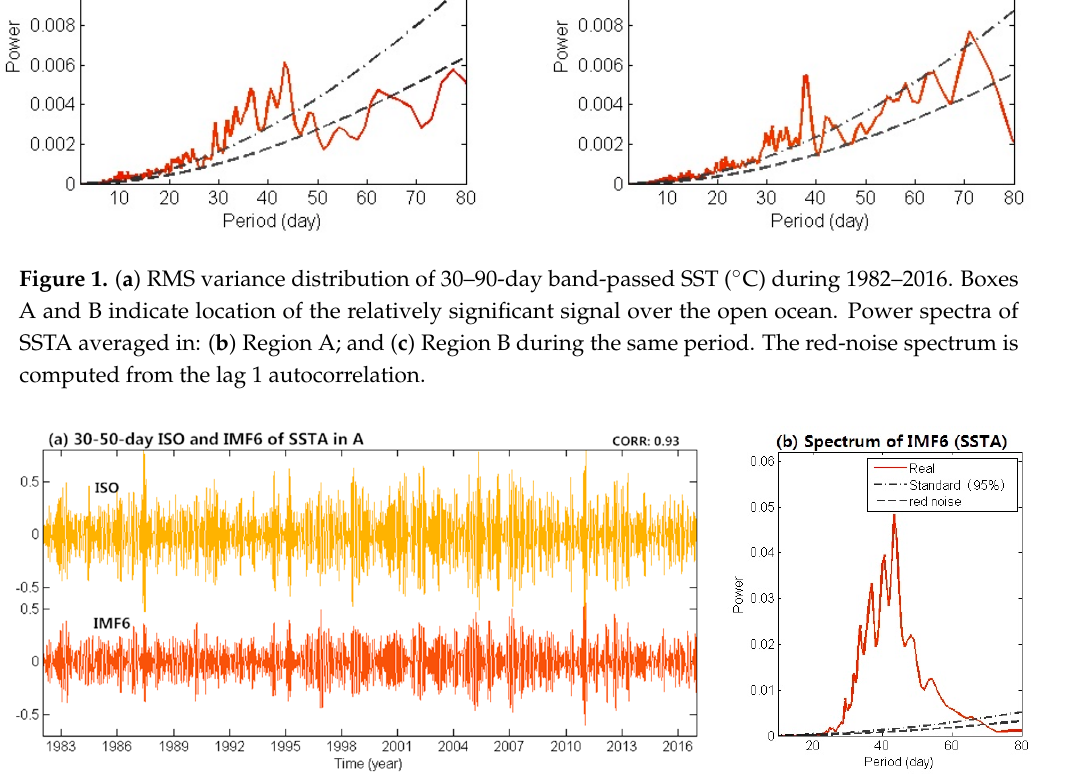
Figure 2. ( a ) The 30 – 50-day ISO (yellow) and IMF6 (red) of SSTA averaged in Region A. Correlation coefficient of the two time-series is 0.93. This result exceeds 95% confidence level by student t-test. ( b ) Spectrum of IMF6. The red-noise spectrum is computed from the lag 1 autocorrelation.